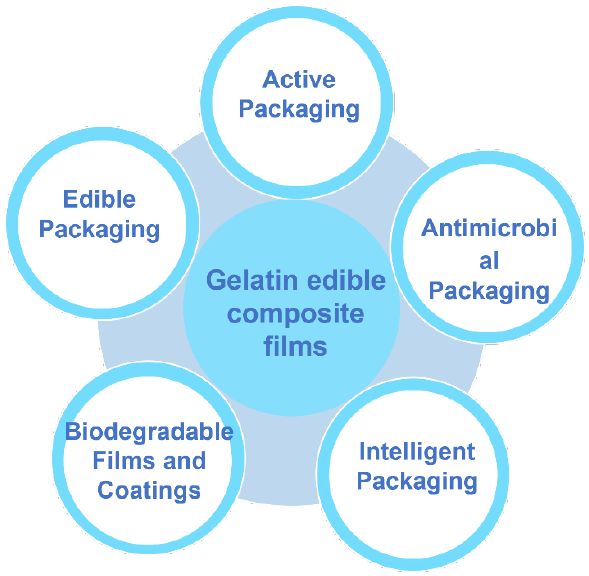
Figure 9. Various food packaging applications of gelatin.